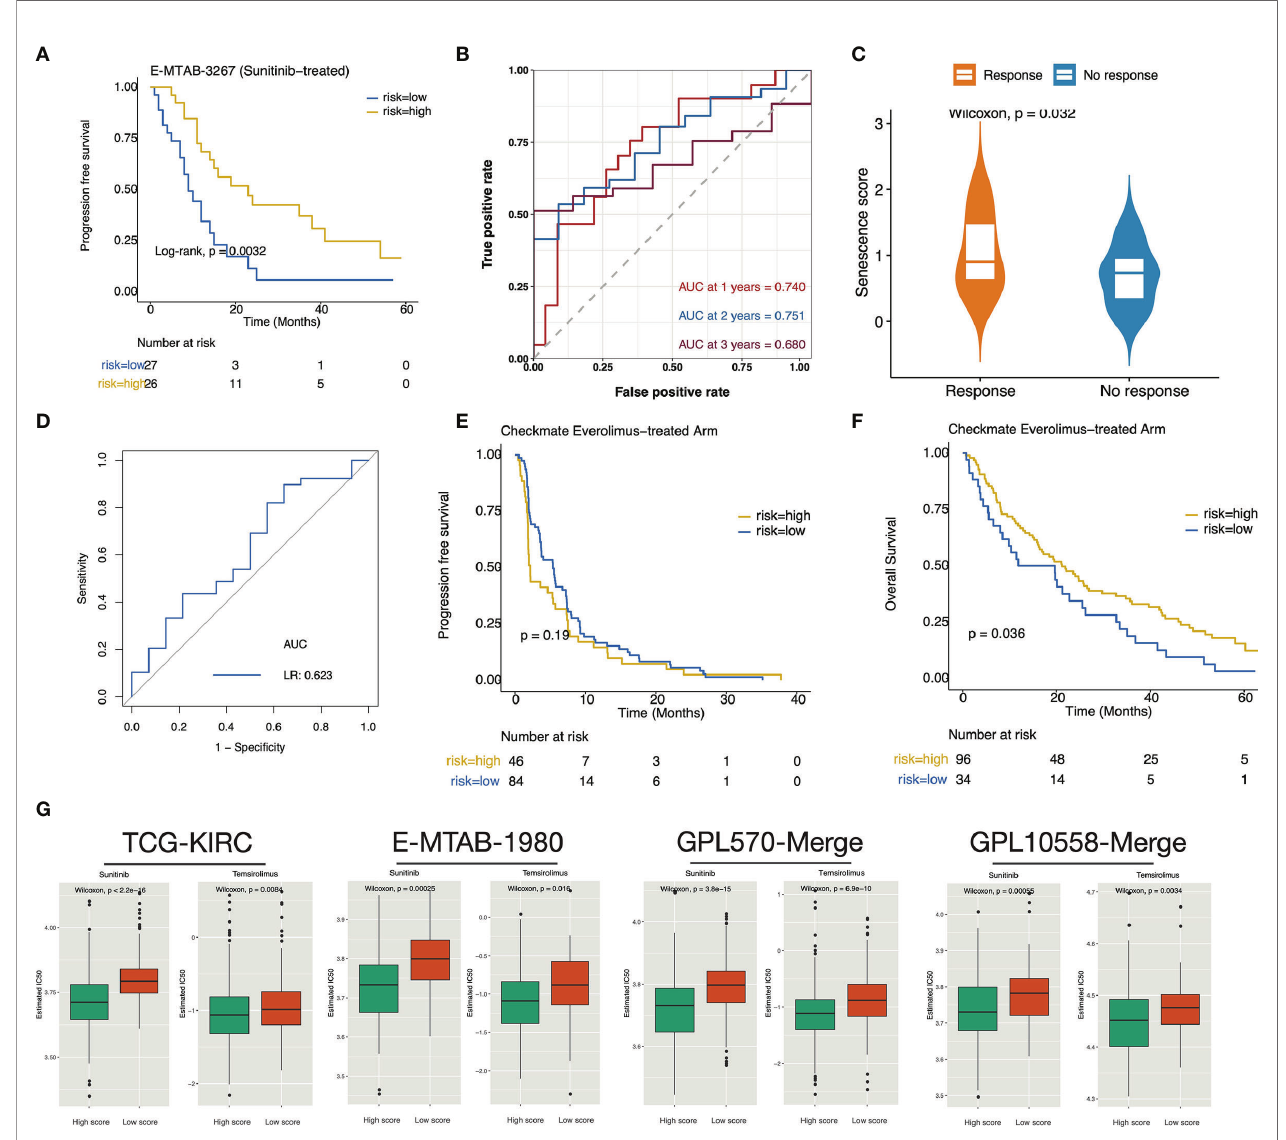
FIGURE 6 | The high senescence score subgroup was correlated with targeted therapy bene fi t. (A) Kaplan – Meier curve exhibited extended PFS time in patients of the high-senescence score groups. (B) The predictive value of the senescence score for PFS after sunitinib treatment. (C) Boxplot showed that the Sunitinib- response group possesses signi fi cantly higher senescence scores. (D) Predictive power of the senescence score for sunitinib response. (E, F) Survival curves showed that the high-score group determined by the surv_cutponit function gained OS bene fi t (F) in Everolimus treatment rather than PFS bene fi t (E) . (G) The predicted IC50 values for Sunitinib and Temsirolimus in the TCGA-KIRC, E-MTAB-1980, GPL570-merge, and GPL10588-merge datasets. A lower IC50 value represents more sensitivity to the drug